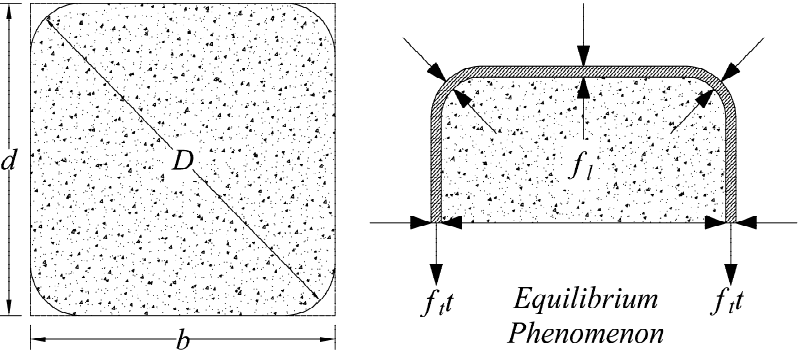
Figure 8. Assumed confinement mechanism of hemp ropes ( 𝑡 is the thickness/diameter of the hemp rope). Table 4. Existing ultimate compressive strength models.